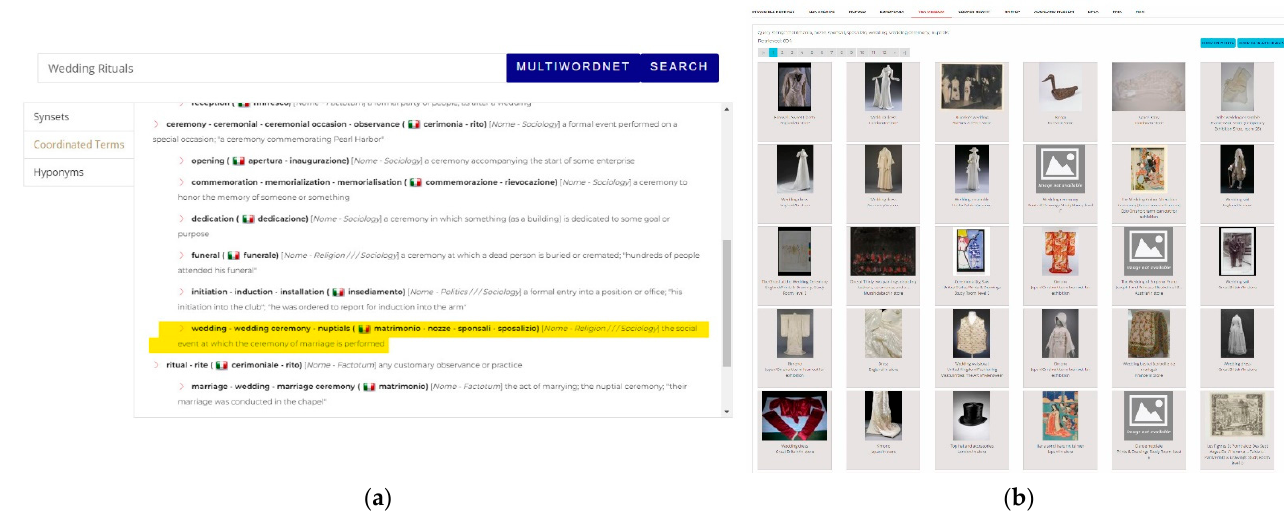
Figure 9. Tag “Wedding Rituals”: ( a ) MultiWordNet synsets; ( b ) results for the selected synset from the Victoria and Albert Museum. the Victoria and Albert